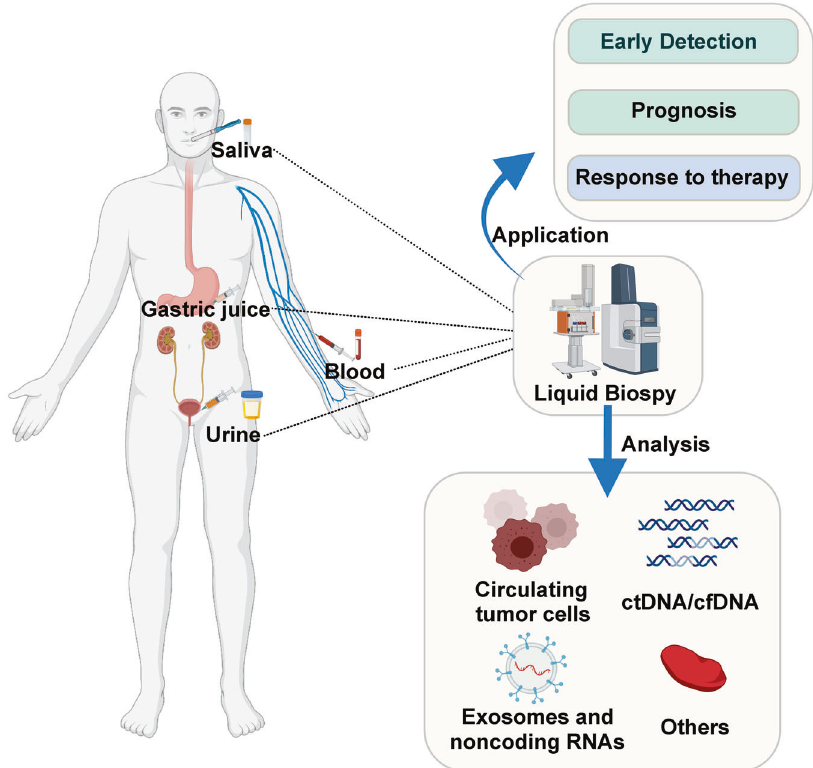
Fig. 1 Flowchart of applying liquid biopsy in GC. Blood, saliva, urine, and gastric juice are collected and targets of liquid biopsies, such as CTCs, ctDNA/cfDNA or exosome RNAs, were enriched to achieve early detection, prognosis, and monitoring therapy